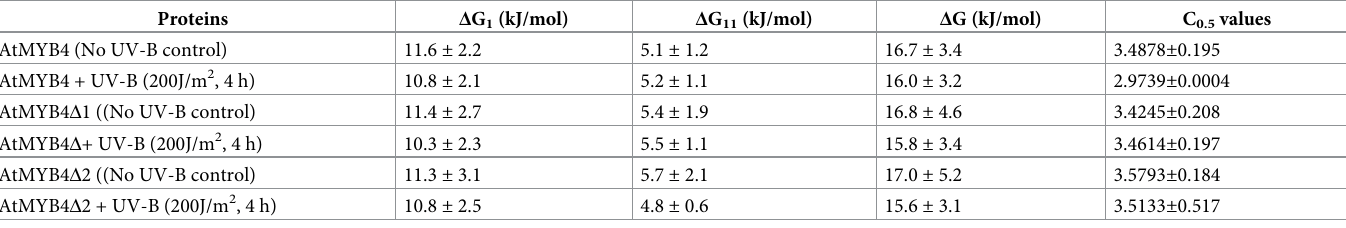
Table 2. Parameters of equilibrium urea unfolding of recombinant AtMYB4 and the N terminus deletion forms of the protein under control and after UV-B treatment.